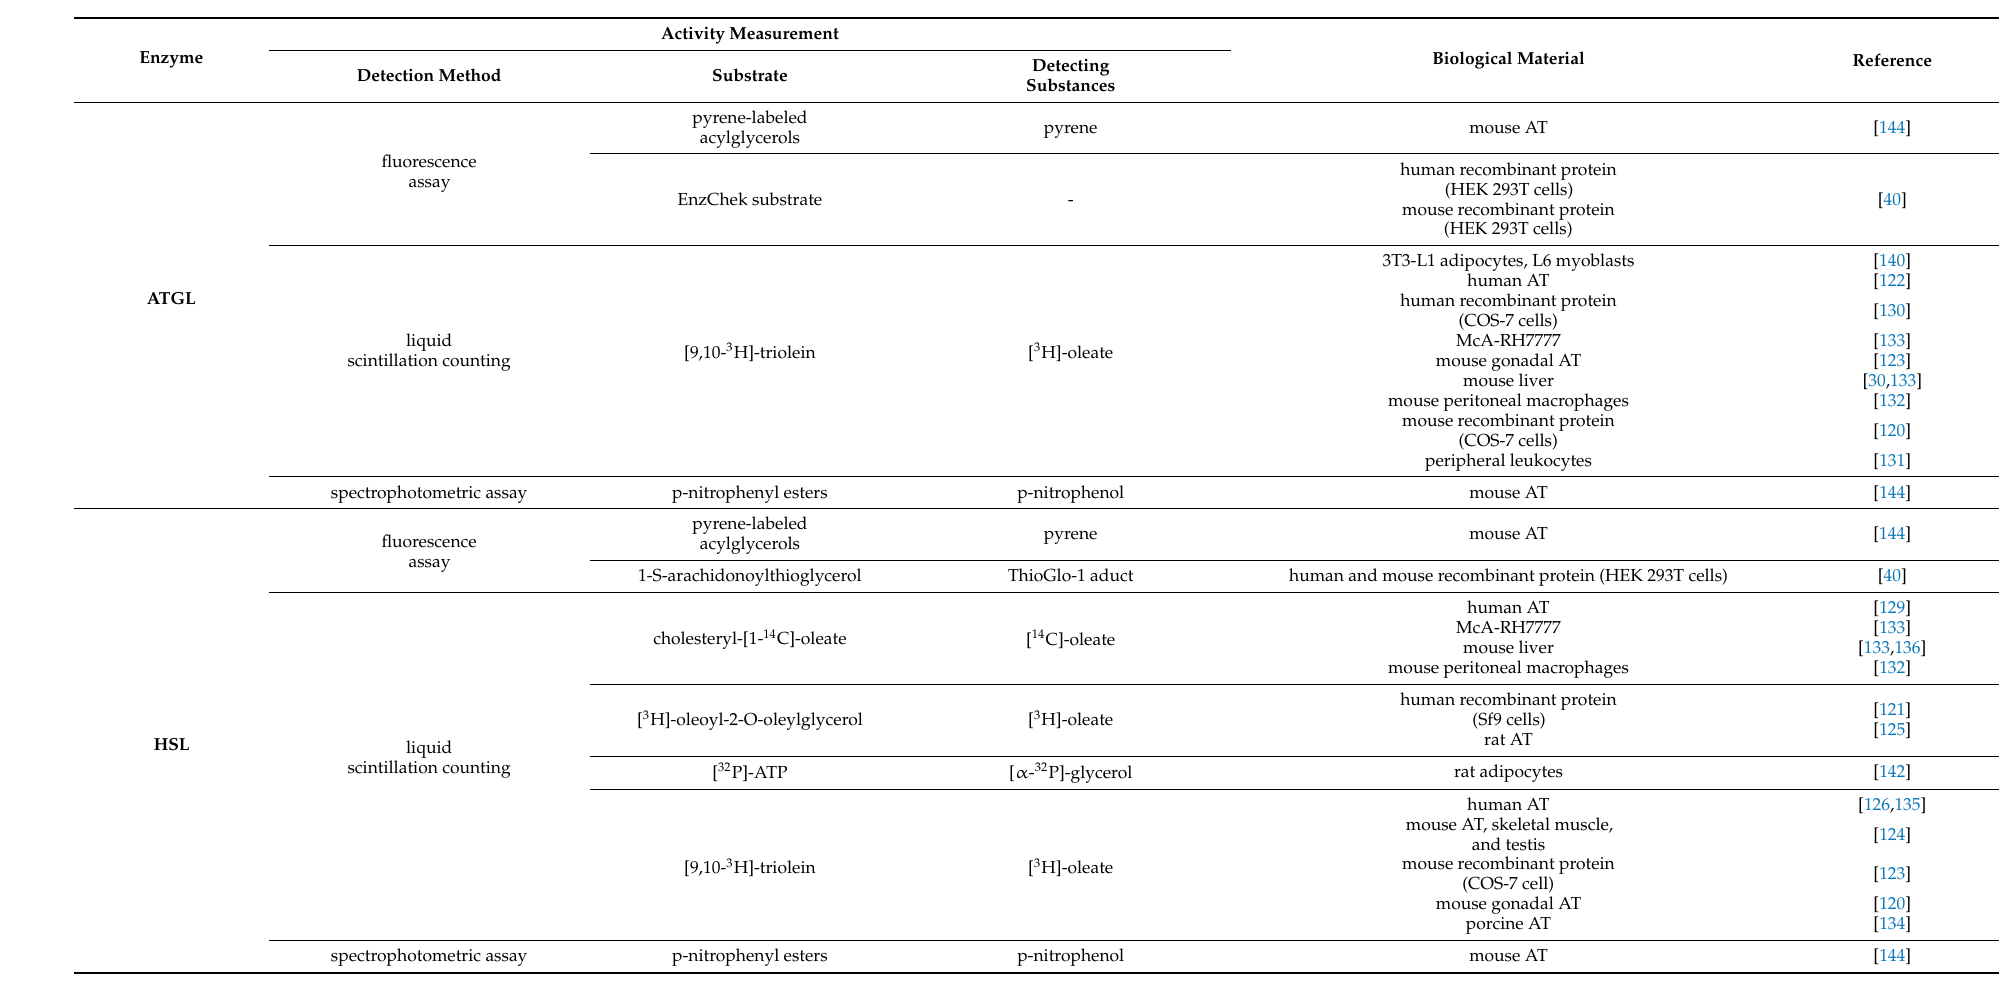
Table 2. Summarizing the determination of ATGL, HSL, ACC, and FAS activity